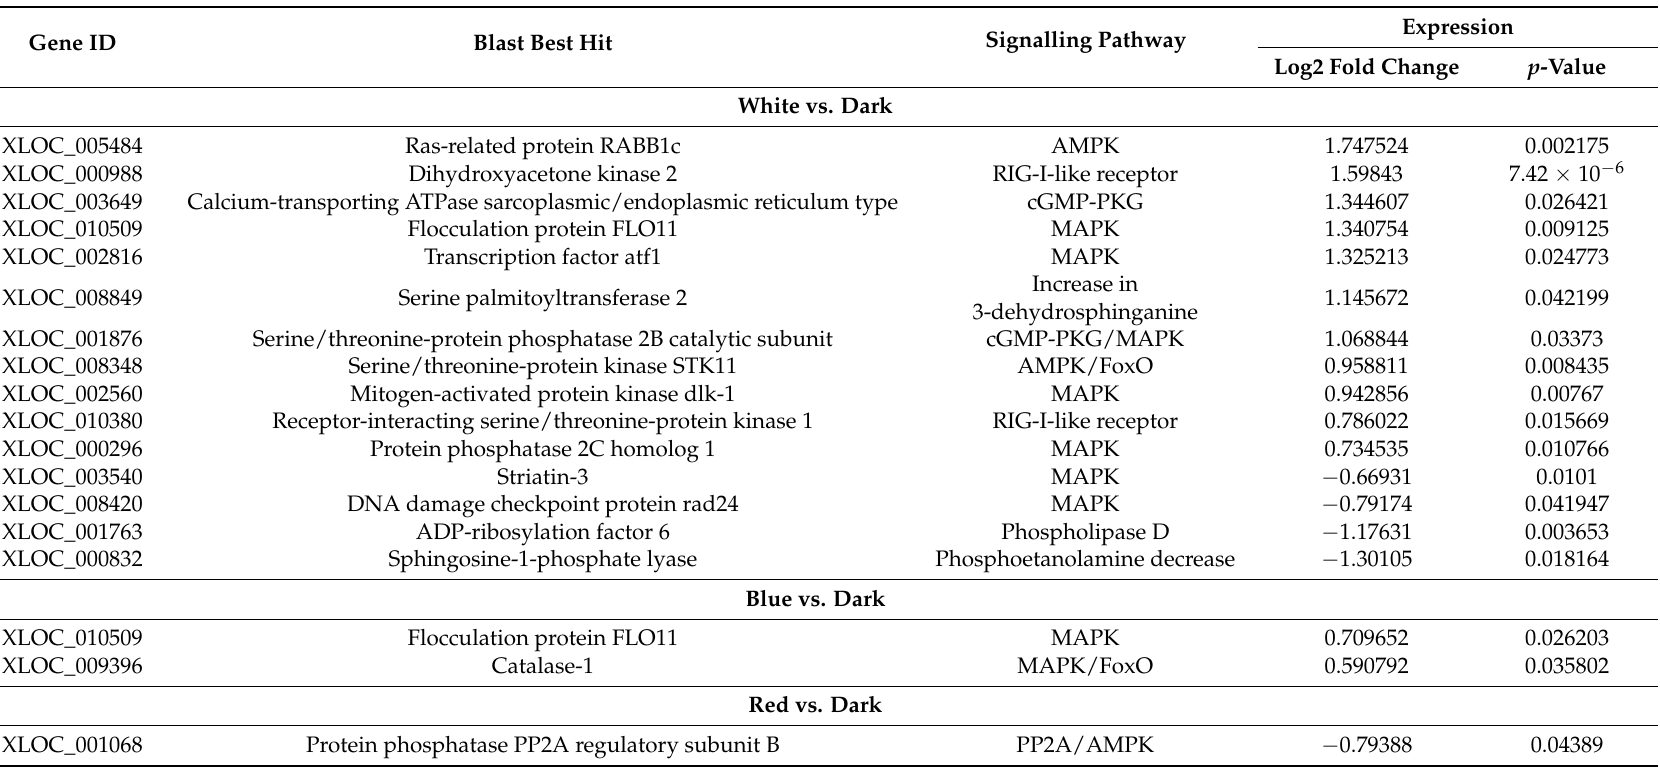
Table A1. C. unicolor differentially expressed genes engaged in signalling pathways detected during fungus growth in different lighting